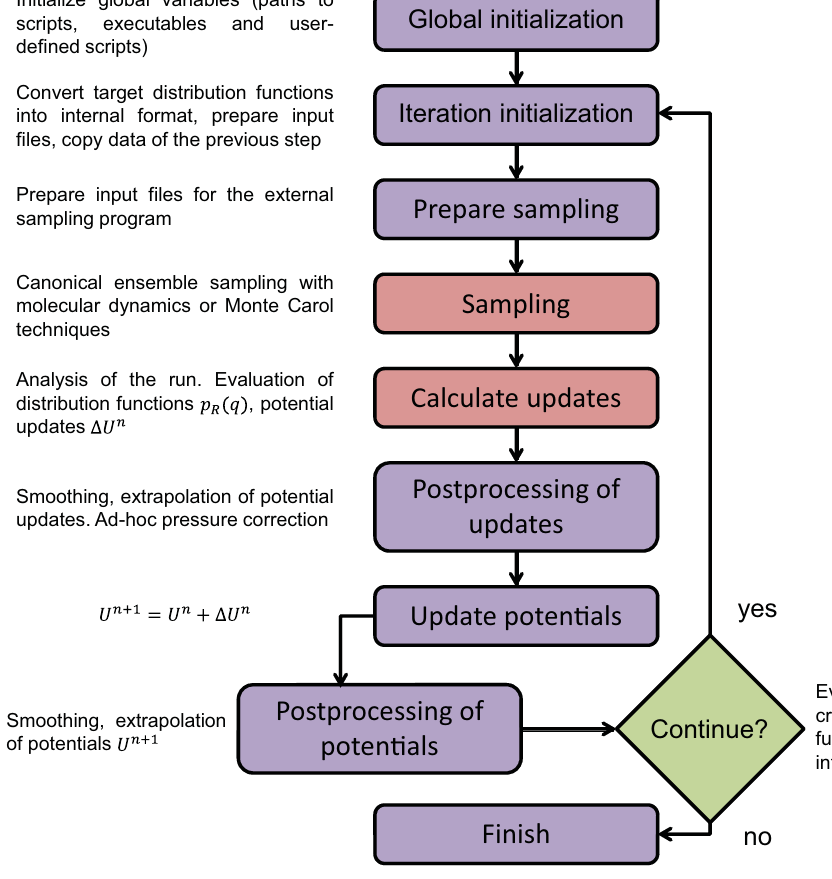
Figure 7. Workflow chart for the Iterative Boltzmann Inversion (IBI) method. The figure is taken and modified from [174].